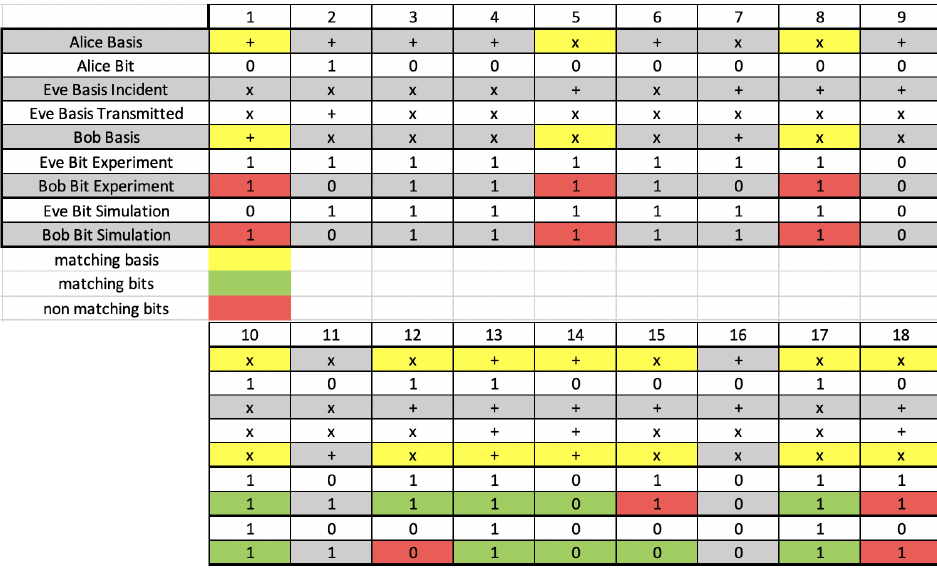
Figure A4. 18 bit transmission results from Alice to Bob with Eve—experiment and